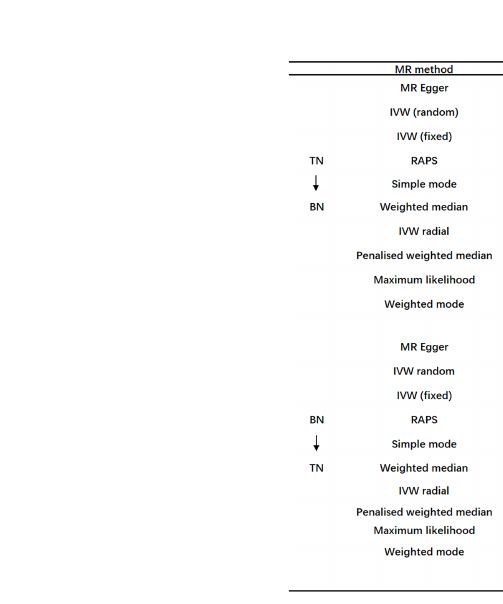
FIGURE 8 OR value of the 10 methods (TN ! BN; BN !